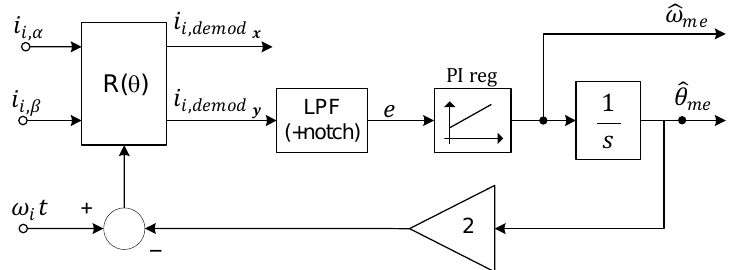
Figure 1. Typical algorithm for position estimation based on rotating-voltage High Frequency Injection (HFI) [7].